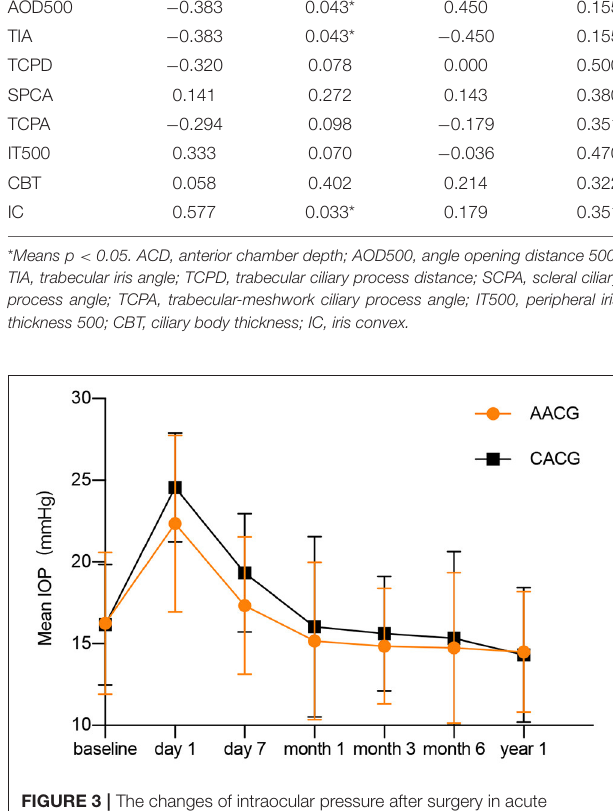
FIGURE 3 | The changes of intraocular pressure after surgery in acute angle-closure glaucoma and chronic angle-closure glaucoma